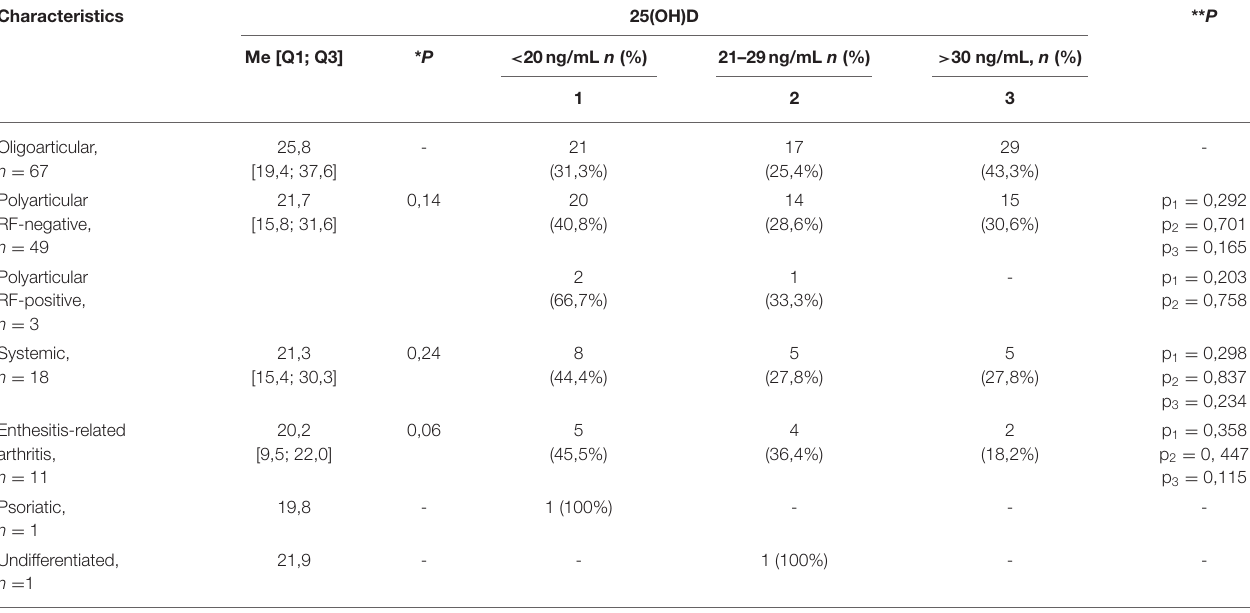
TABLE 5B | The distribution of vitamin D provision for patients with JIA depending on the form of the disease.